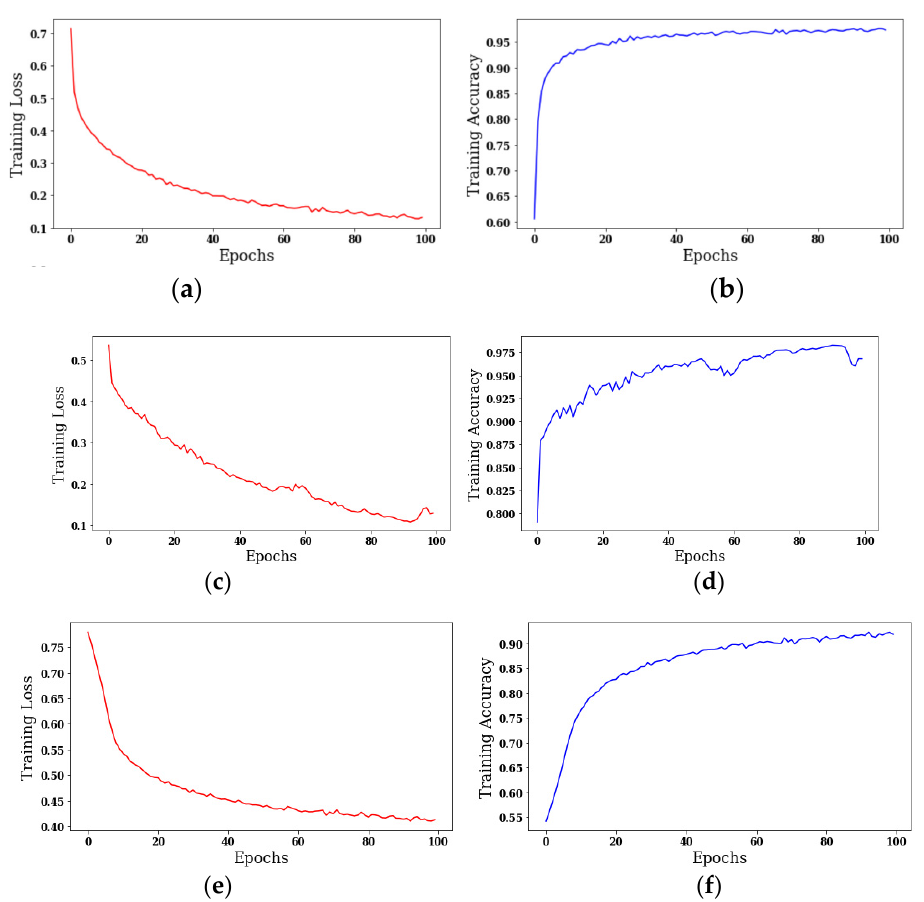
Figure 5. Analysis of training loss and training accuracy: ( a ) Training Loss with SGD optimizer, ( b ) Training Accuracy with SGD optimizer, ( c ) Training Loss with Adam optimizer, ( d ) Training Accuracy with Adam optimizer, ( e ) Training Loss with Adadelta optimizer, ( f ) Training Accuracy with Adadelta optimizer’s Original Image.